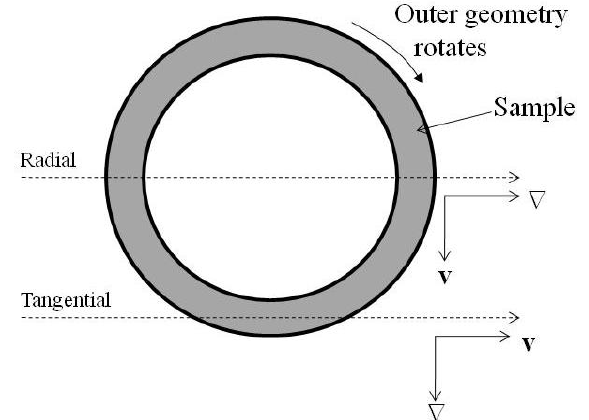
Figure 1. Schematic top view of the concentric cylinder shear cell showing the path of the beam in both the radial and tangential scattering geometries. The velocity vector ( v ) and shear gradient vector ( ∇ ) are shown for each, while the vorticity vector ( e ) is normal to the